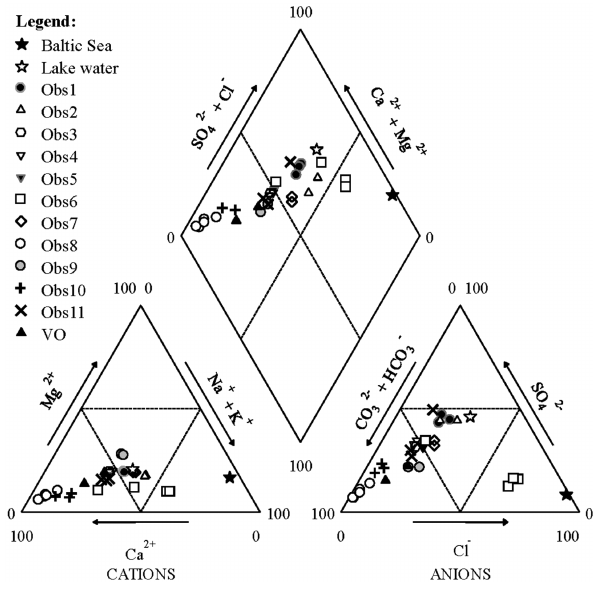
Figure 6. Piper diagram showing the major ion chemistry of groundwater and surface water samples from Santala,